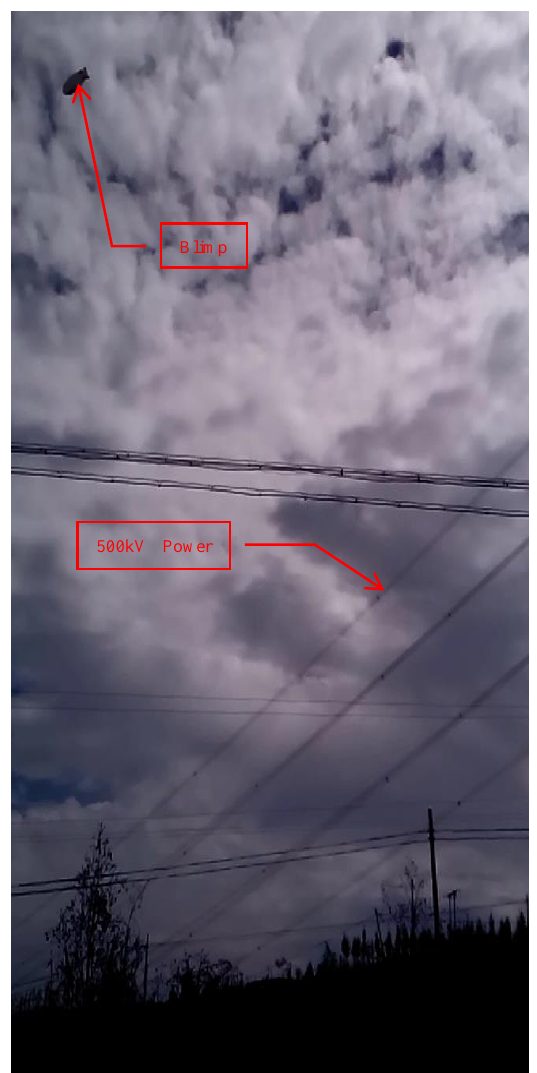
Figure 5. Power-line inspection scene